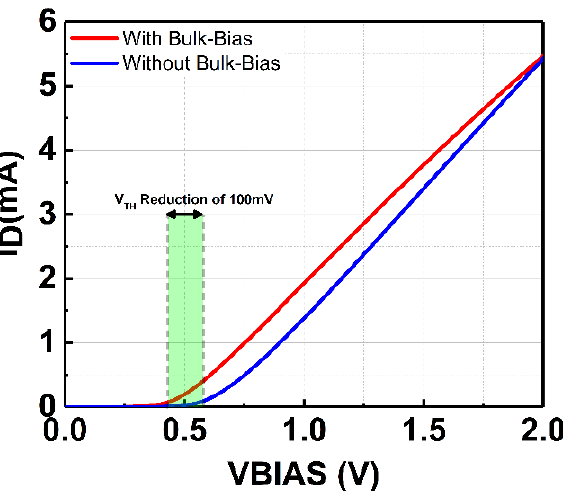
Figure 3. Drain current (I D ) comparison without and with bulk-biasing. 100 mV V TH reduction is achieved with a bulk-biasing mechanism.